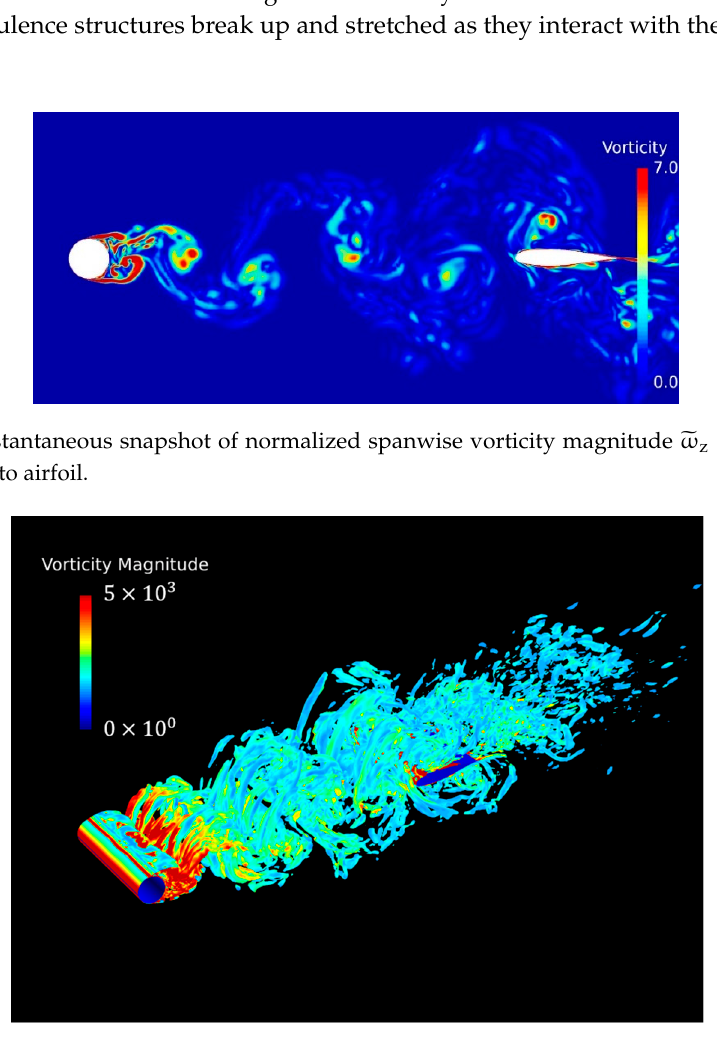
Figure 19. Instantaneous iso-surface of Q-criterion from cylinder to airfoil.